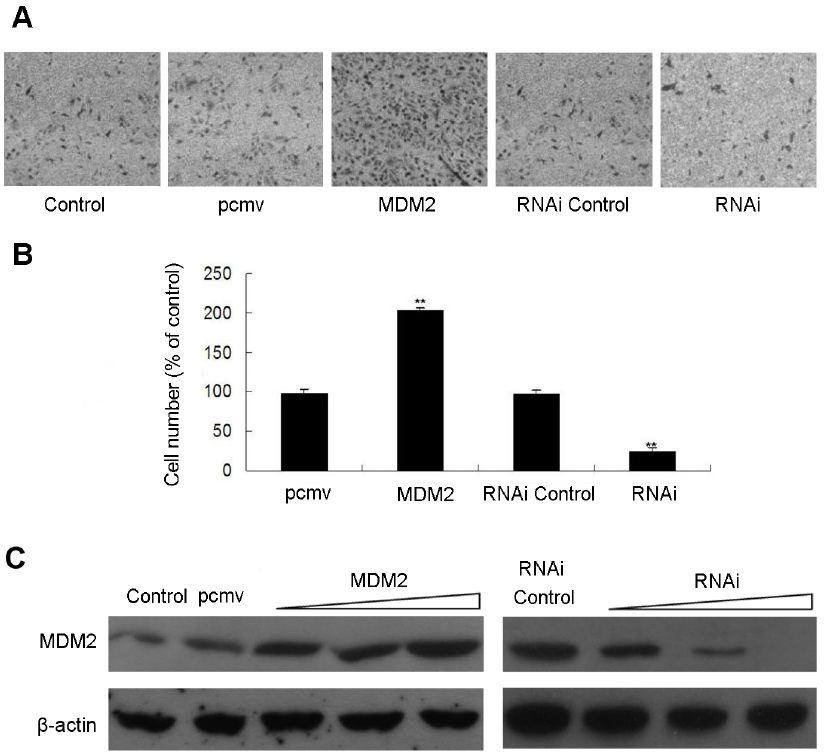
Figure 6. MDM2 promotes the invasion of MDA-MB-231 cells. MDA-MB-231 cells were transfected with pcmv-MDM2 expression plasmids and pcmv vectors, siRNAs against MDM2 or non-specific siRNA (controls). After 48 h, the cells were plated onto a Matrigel to assay cell invasion. Cells were allowed to migrate for 20 h at 37 u C. Cells on the upper side of the inserts were removed with a cotton swab. Cells that migrated to the lower side of the filters were stained with 1% crystal violet and counted under light microscopy. (A) Digital pictures of cell invasiveness. Stained areas represent the numbers of invasive cells, and all images are representative of three independent experiments; ( B) Number of invasive cells compared to the control (expressed as the percentage of the control). (C) The levels of MDM2 protein were detected using Western blot analysis in MDA-MB-231 cells that over- or under-expressed MDM2 (plasmid or siRNA transfection) and control cells. b -actin levels served as internal control.